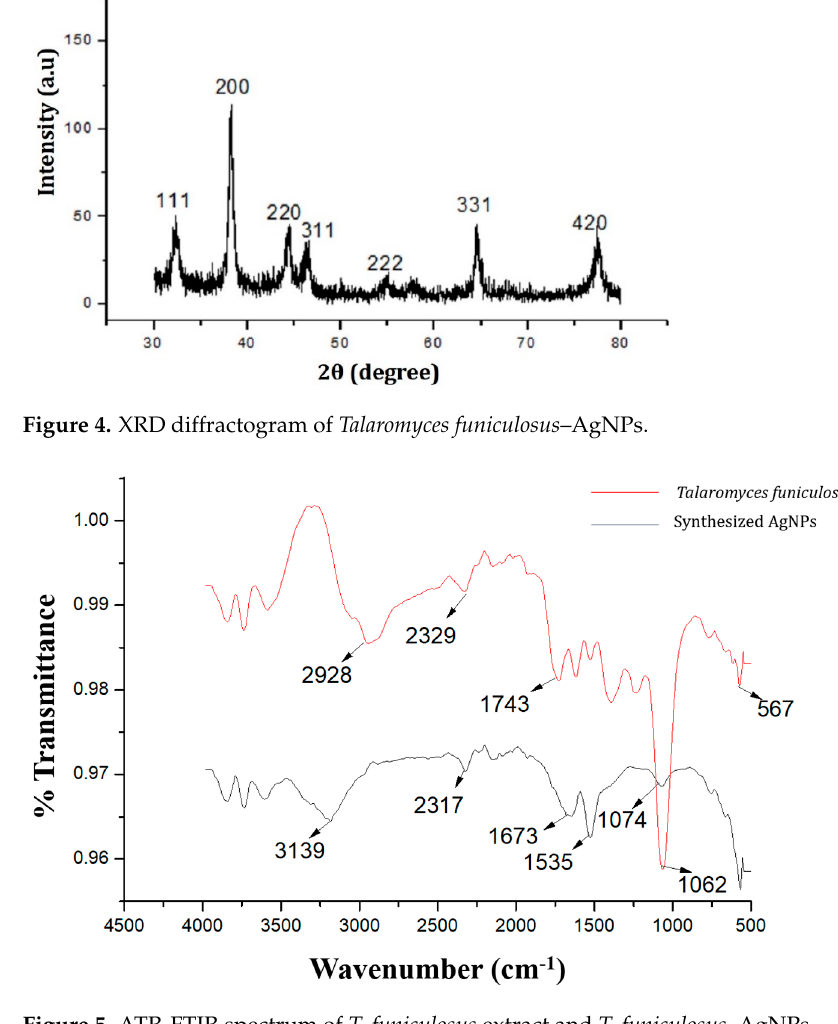
Figure 6. Determination of MICs of T. funiculosus –AgNPs against foodborne pathogens using mi- crobroth dilution; standard deviation is shown. Significant difference ( p ≤ 0.05).